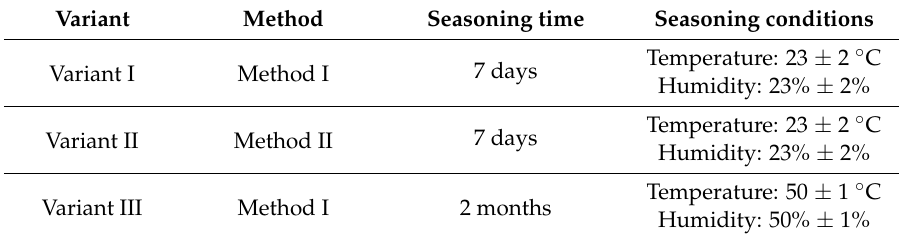
Table 3. Conditions of specimen preparation for strength testing.